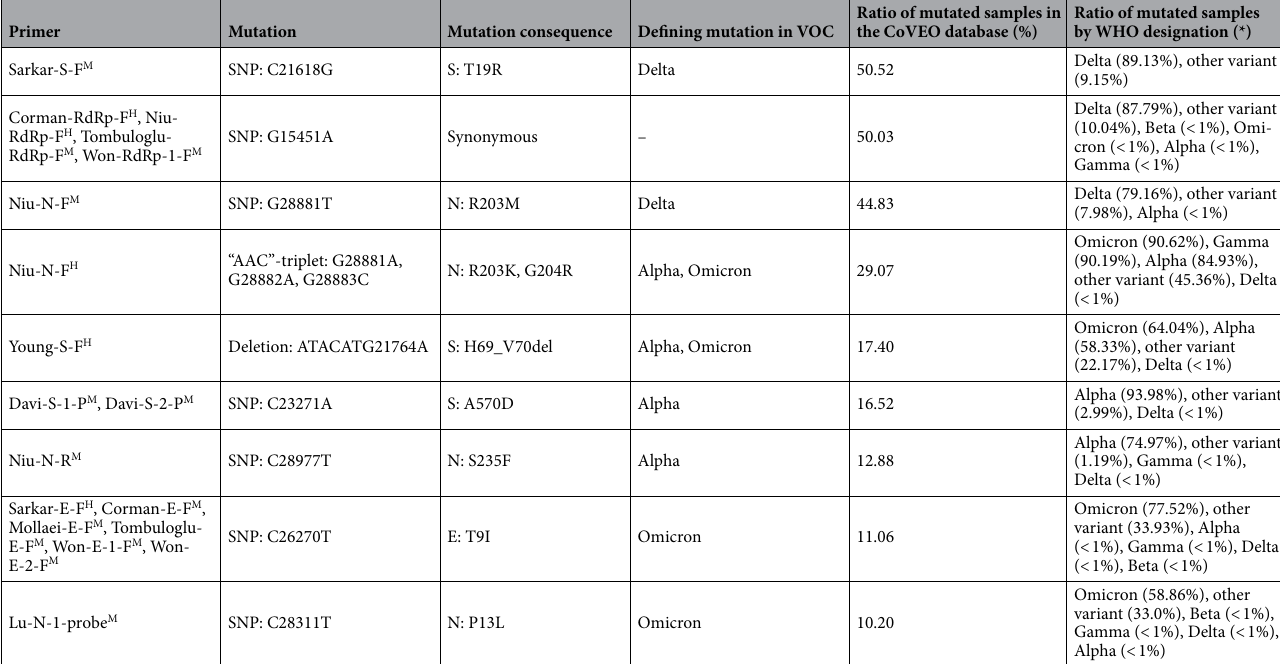
Table 3. Summary of the most frequent mutations in the TRs of investigated PCR primer systems. For more details, regarding mutation position and estimated effect in the different primers, see Supplementary Table